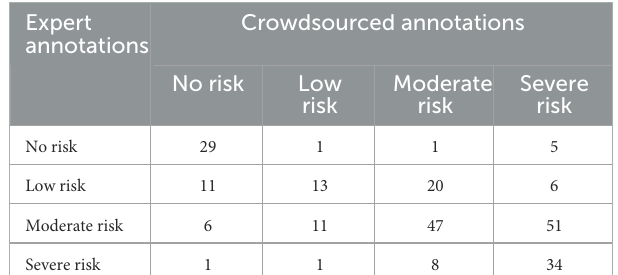
TABLE 2 Crowdsourced against expert